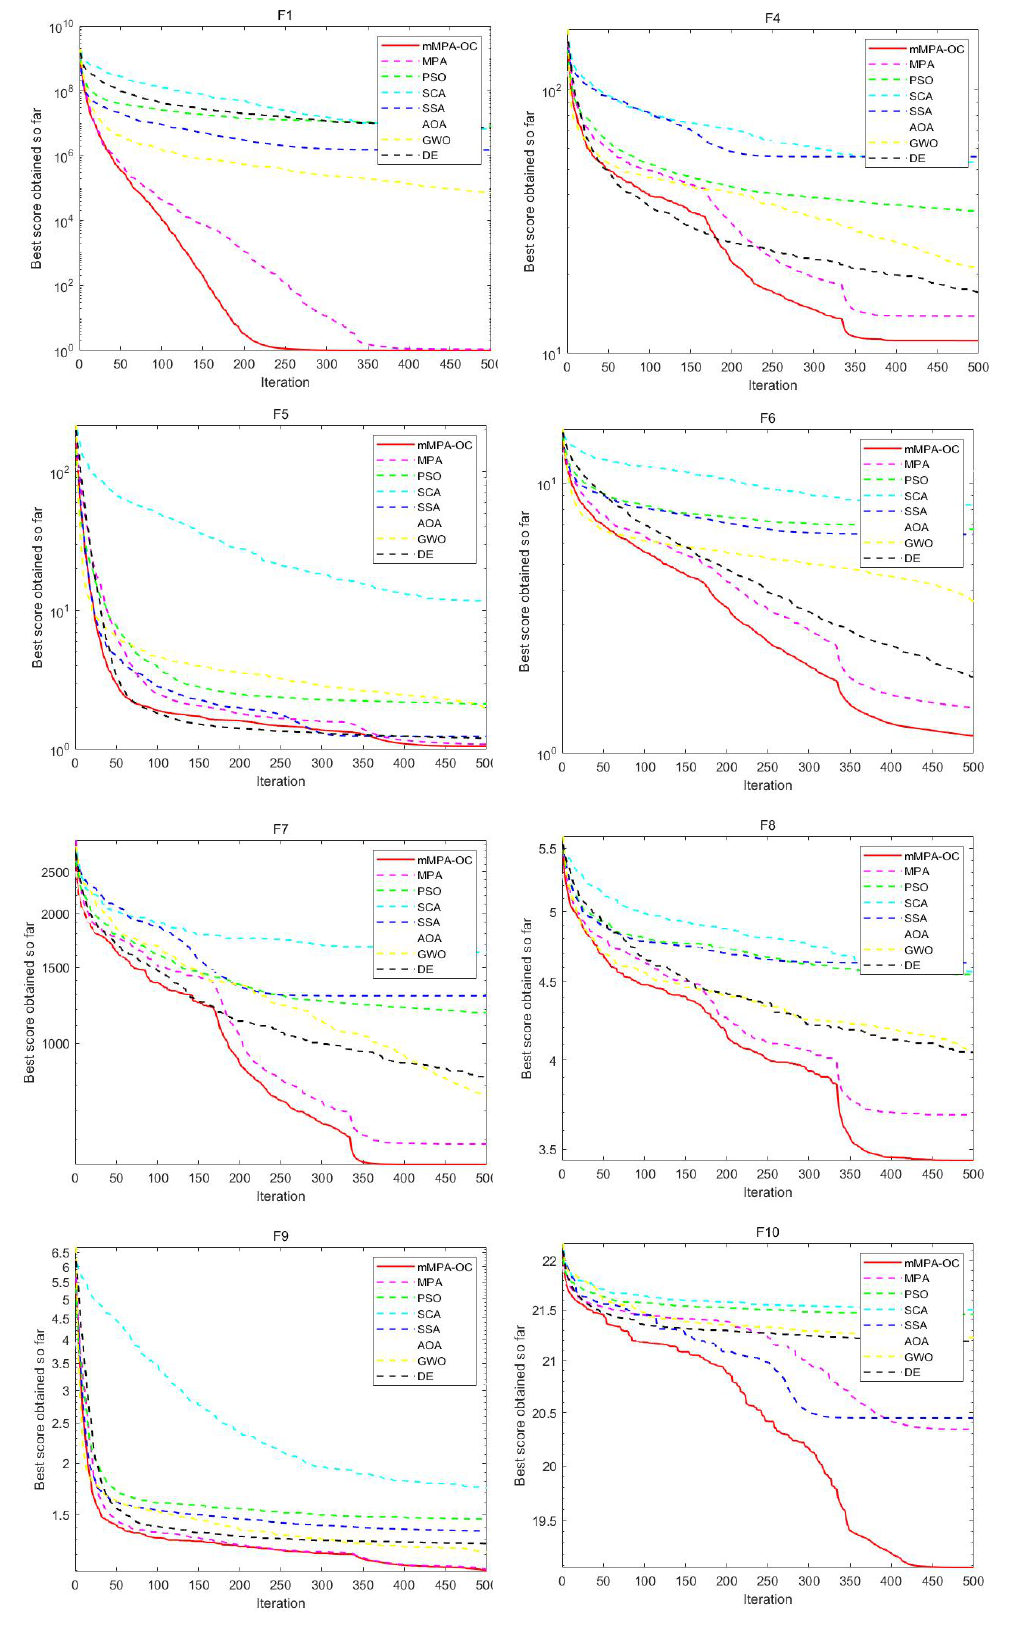
Figure 5. Convergence curve of CEC-2019 test